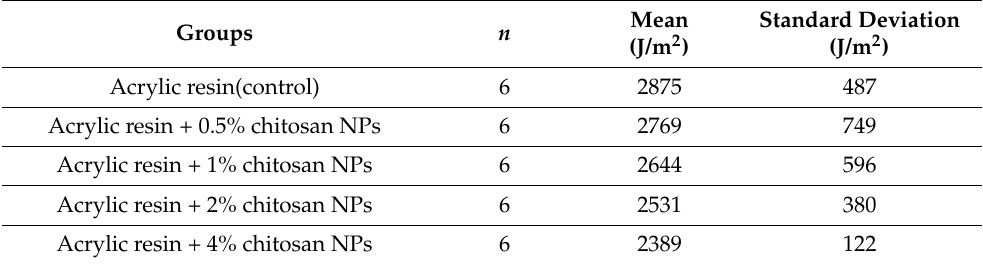
Table 6. Mean and standard deviation of the impact strength in five different groups ( p >